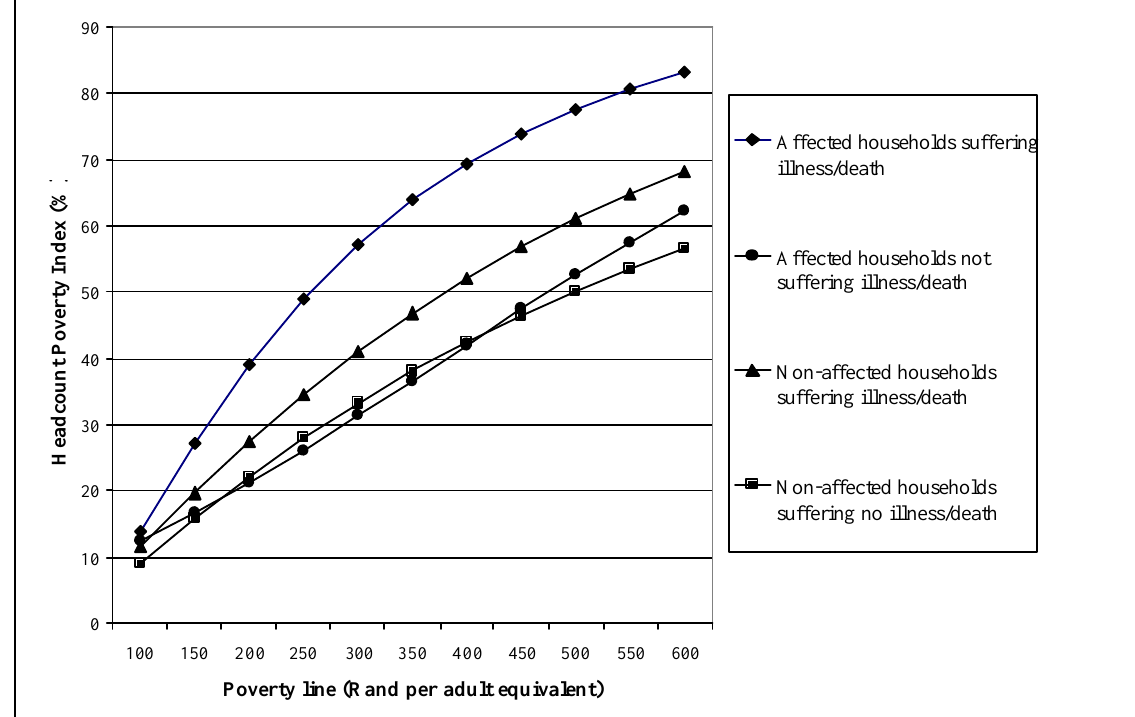
Incidence of poverty in affected and non-affected households by incidence of illness and/or death (wave